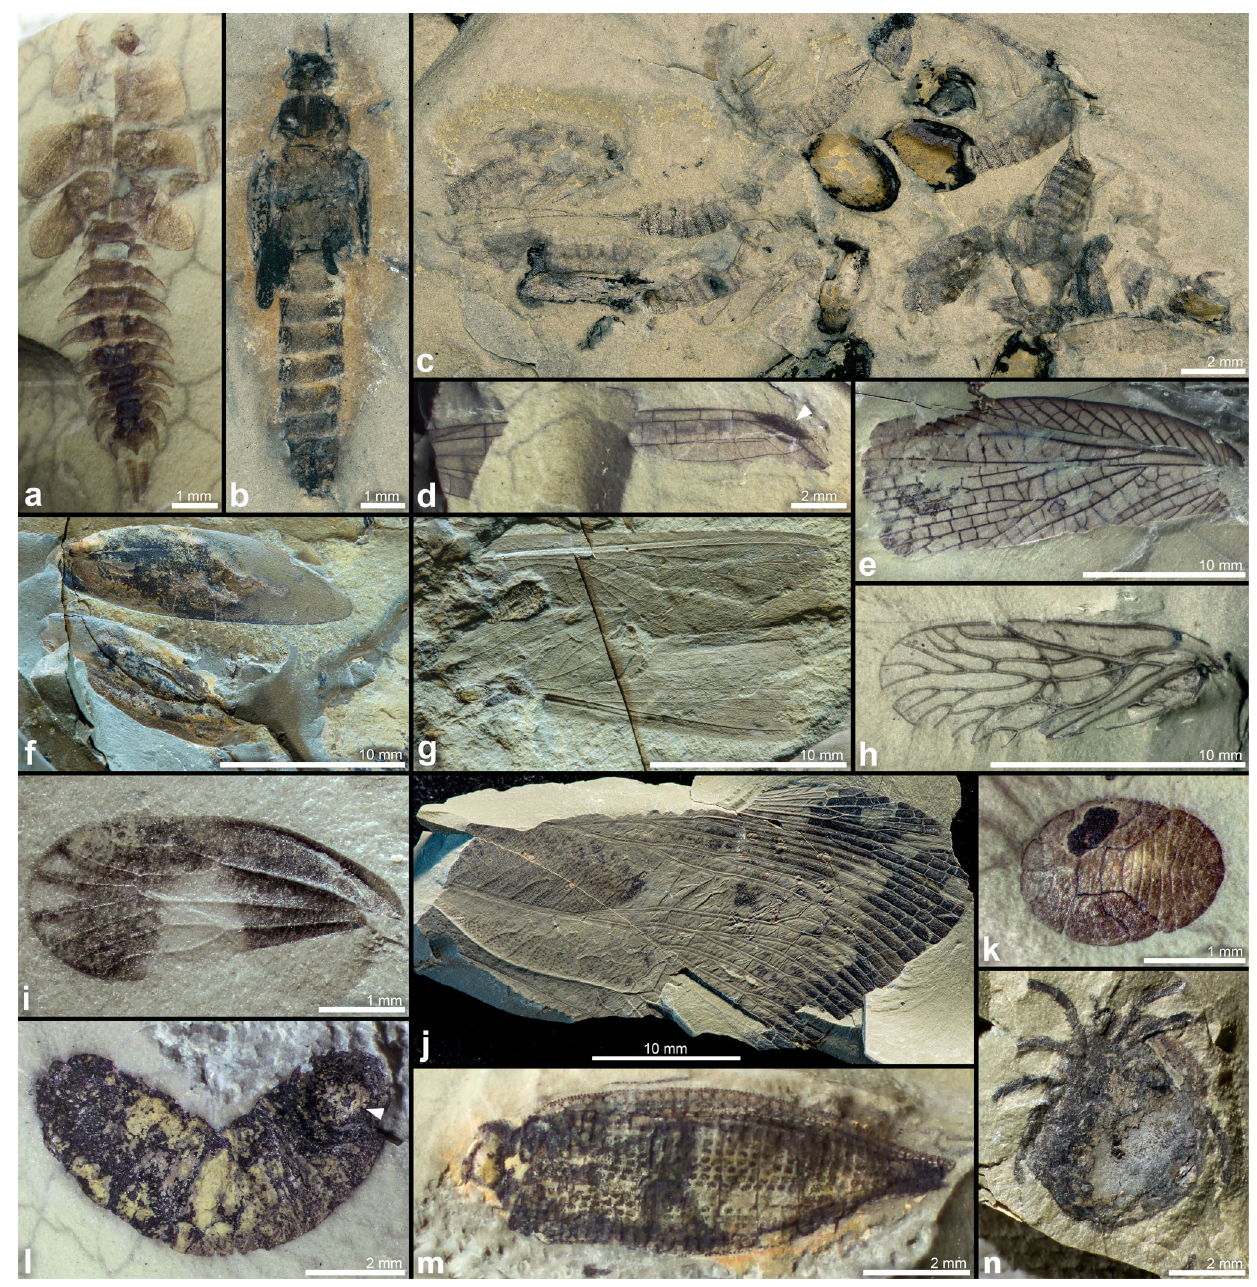
Fig. 5 A selection of newly discovered invertebrate fossils from the Onder Karoo locality. a AM14859: exuviae of a nymph (Palaeodictyopterida). b AM13265: stone fl y nymph (Plecoptera). c AM11348: cluster of plecopteran nymph exuviae associated with glossopterid seeds. d AM11296: distal fragment of a wing of Afrozygopteron inexpectatus 45 , a Protozygoptera (an early damsel fl y-like Odonatoptera), with sclerotized costo-apical pterostigma (arrow). e AM11389: forewing of an ‘ ice crawler ’ , Colubrosopterum karooensis (a new genus of ‘ Grylloblattodea ’ , Liomopteridae 46 ). f AM14864d: two forewings of Protelytoptera. g AM14864e: two forewings of Anthracoptilidae (Paoliida). h AM14858ab: composite image of part and counterpart of a hemipteran forewing (Prosbolidae). i AM11298a: hemipteran forewing with pattern of wing colouration preserved (Scytinopteridae). j AM11157a: large forewing of a cicadamorph with pattern of colouration preserved (Hemiptera, Pereboriidae). k terrestrial nymph/nymph exuviae (Hemiptera, Sternorrhyncha). l annelid worm, probable Clitellata (leech) with circular sucker (arrow). m AM11282b: elytron of a beetle with punctate ornamentation (Coleoptera, Permocupedidae). n AM14856: water mite (Acari,